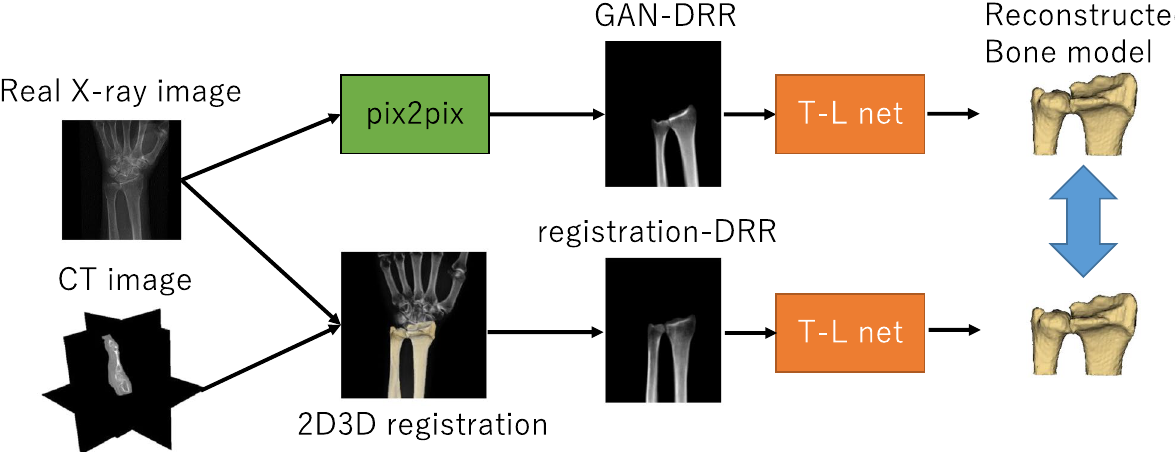
Figure 5. Adaptive results of a bone-segmented, histogram-matched, actual X-ray image. Blue line: ratio of total pixels. Orange line: cumulative ratio of total pixels.